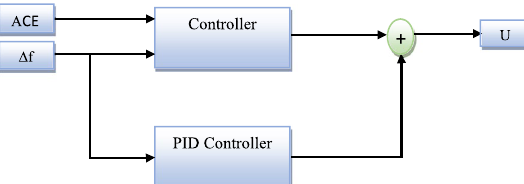
Fig. 4 Block diagram controller structure of combined controller in ALFC